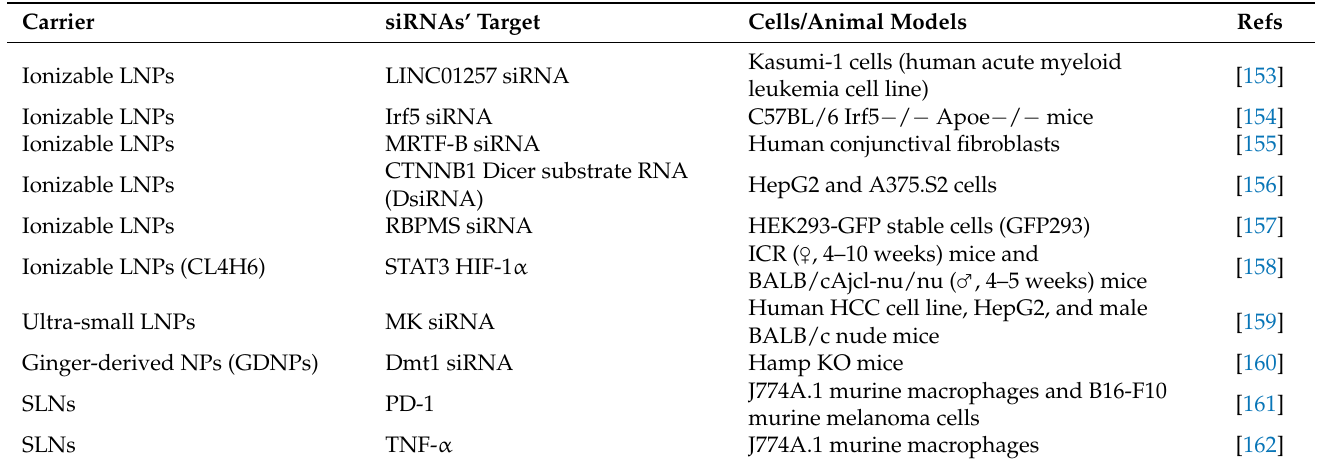
Table 2. Lipid nanocarriers loaded with therapeutic